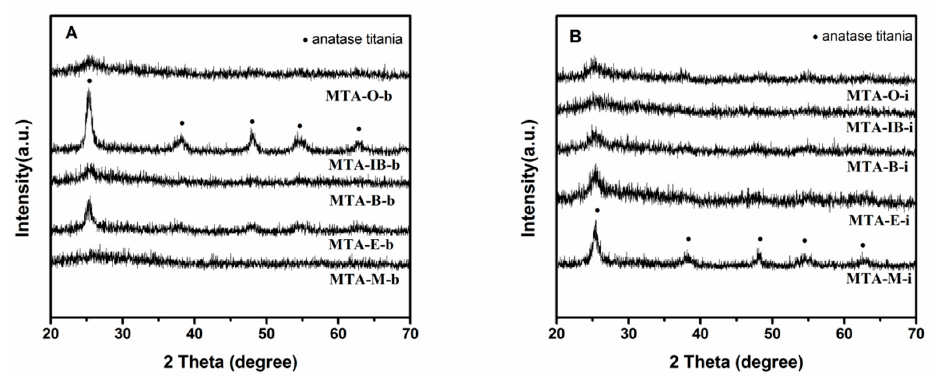
Figure 4. XRD patterns of samples MTA-b ( A ) and MTA-i ( B ) after calcination at 550 °C.